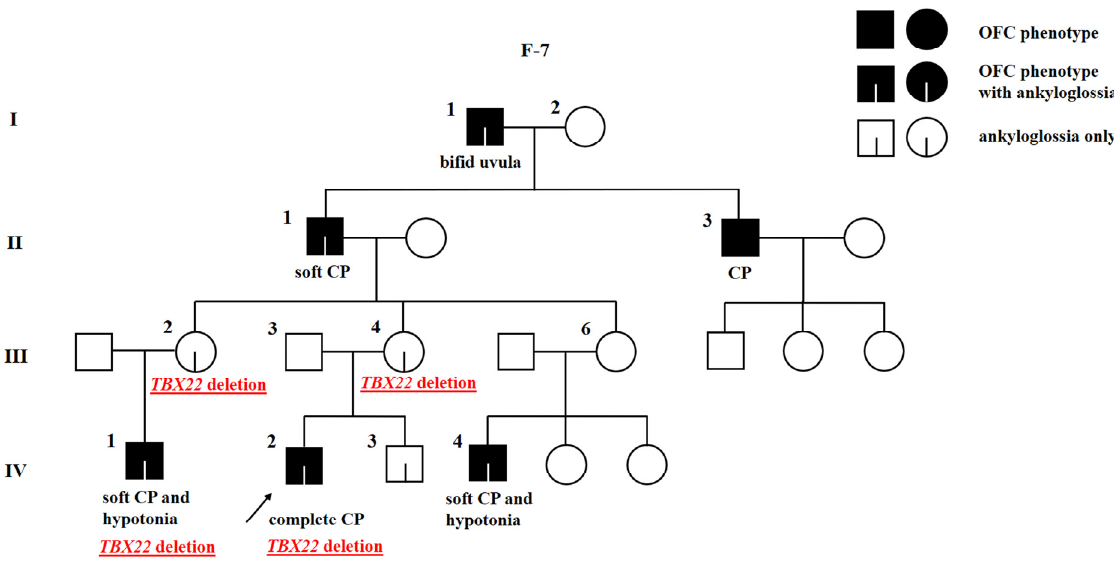
Figure 3. Pedigree of family 7 (F-7) with X-linked cleft palate with or without ankyloglossia and deletion of TBX22 . The proband is marked with an arrowhead. Genotype is given underneath each genetically tested individual. Roman numerals stand for the generations, while Arabic numerals stand for the individual members of the family. OFC, orofacial cleft; CP, cleft palate.